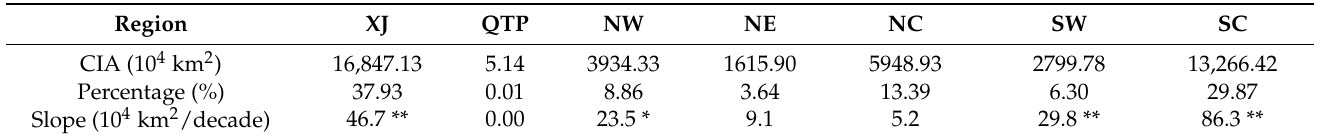
Table 3. The cumulative influence area (CIA) of heatwave events in seven regions of China during the period of